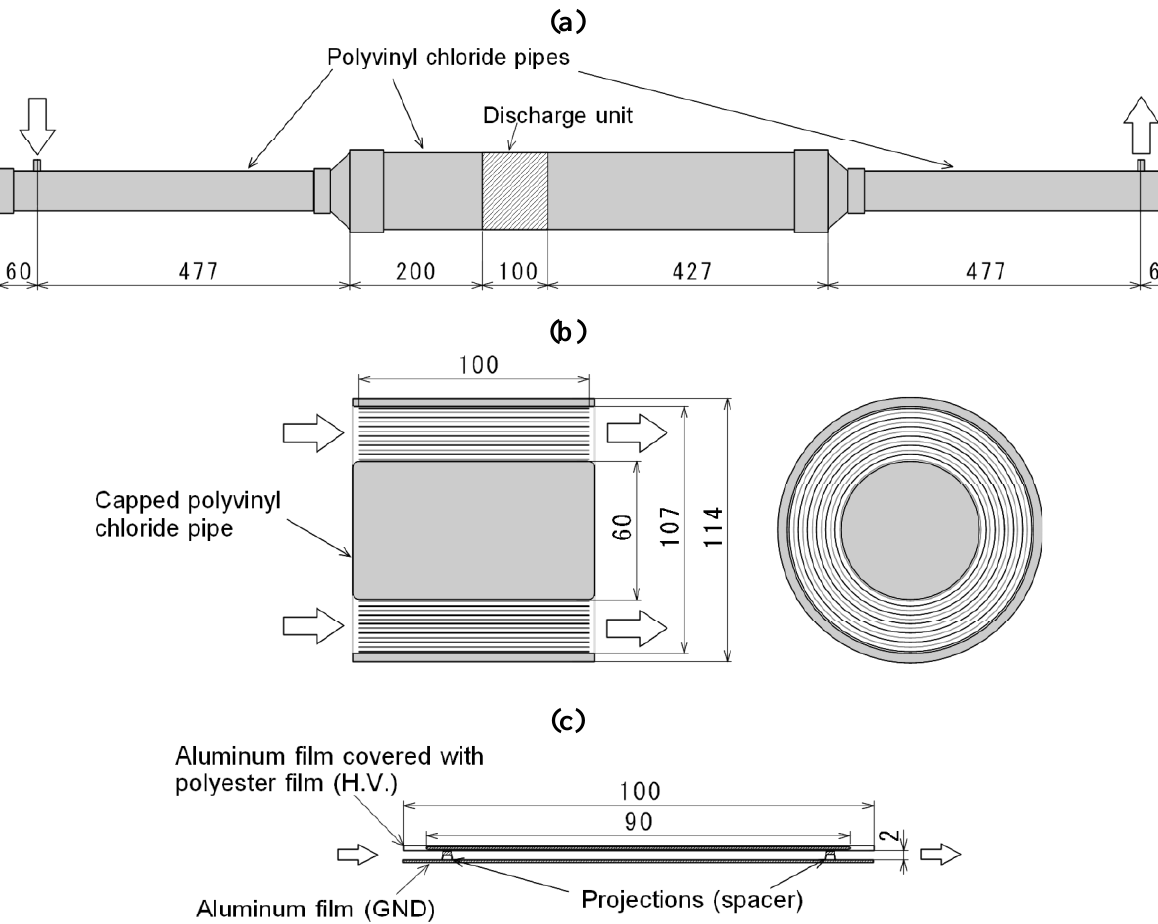
Figure 2. Laminated film-electrode plasma reactor. (a) Schematic of odor removal test section; (b) Configuration of plasma reactor (Discharge unit); (c) Detail of laminated film